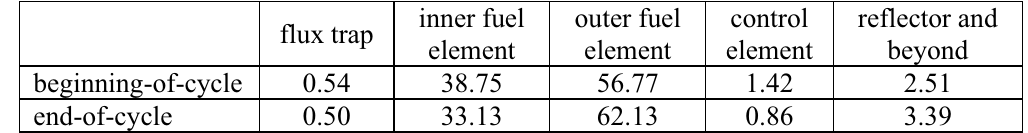
Table IV. Power [%] deposited in various regions of the Optimized core design.